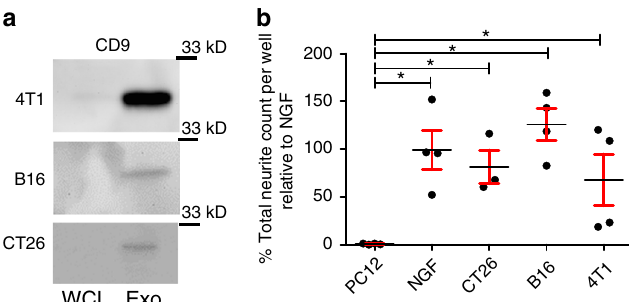
Fig. 8 Exosomes from multiple cancer cell lines harbor neurite outgrowth activity. a Western blot analysis of whole cell lysate (WCL) or exosomes (Exo) from the indicated cell lines. Western blots have been cropped for clarity and conciseness. b Quanti fi cation of neurite outgrowth of PC12 cells following exosome stimulation from the indicated cell lines. Statistical analysis by one-way ANOVA with post hoc Fisher ’ s Least Signi fi cant Difference (LSD) test. LSD p values reported; * p <0.01. All comparisons and LSD p values found in Supplementary Table 6. The variance between the groups statistically compared is similar. Central value used was the mean. n = 4 technical replicates/condition; experiment repeated at least 3 times with biological replicates. Error bars, standard